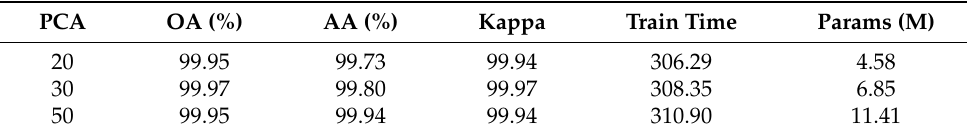
Table 5. Experimental results with different PCA coefficients on the SA dataset.